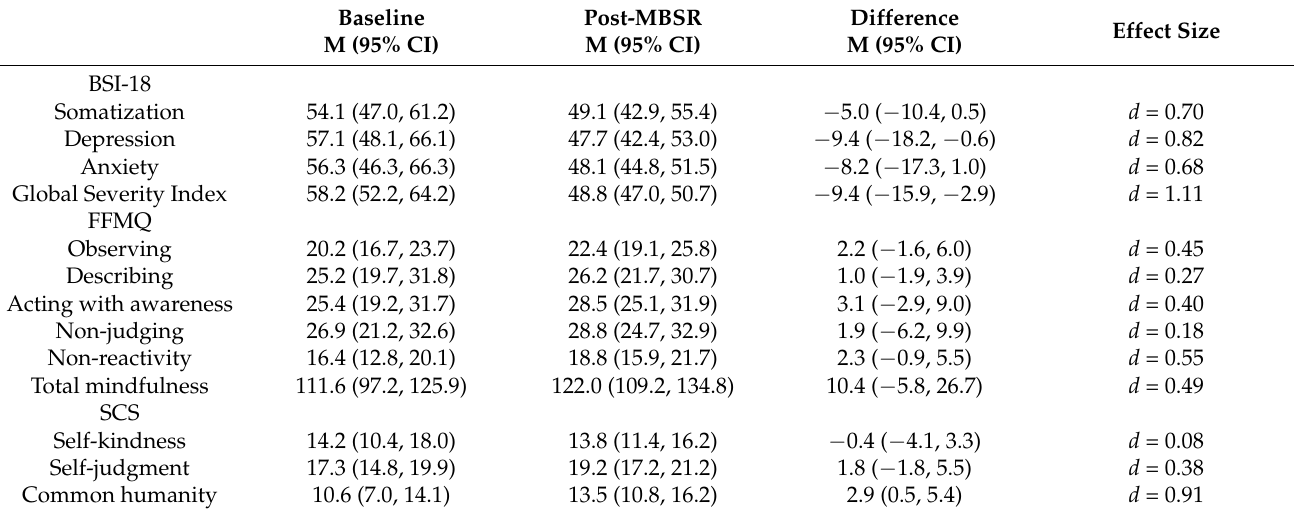
Table 3. Means, Differences, and 95% Confidence Intervals (CI) on Outcome Measures ( n =